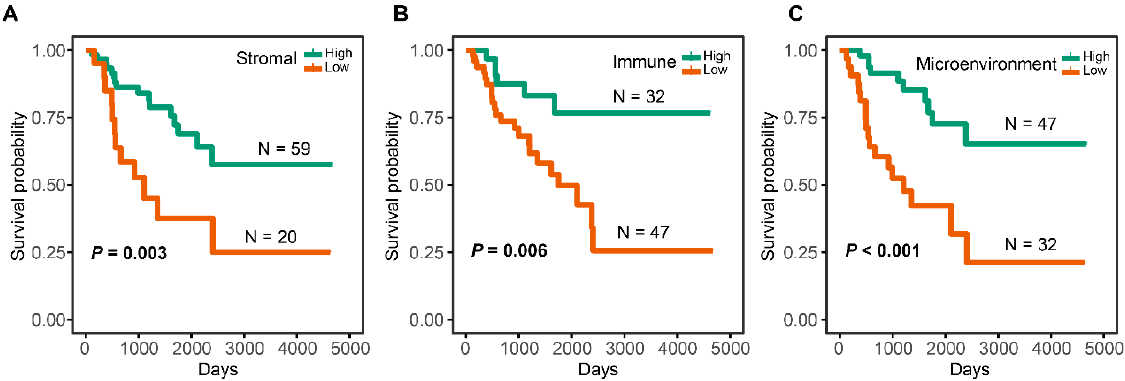
Figure 2. The relationship between TME-related scores and OS. ( A ) KM curves for patients with high- and low-stromal scores. ( B ) KM curves for patients with high- and low-immune scores. ( C ) KM curves for patients with high- and low-microenvironment scores.